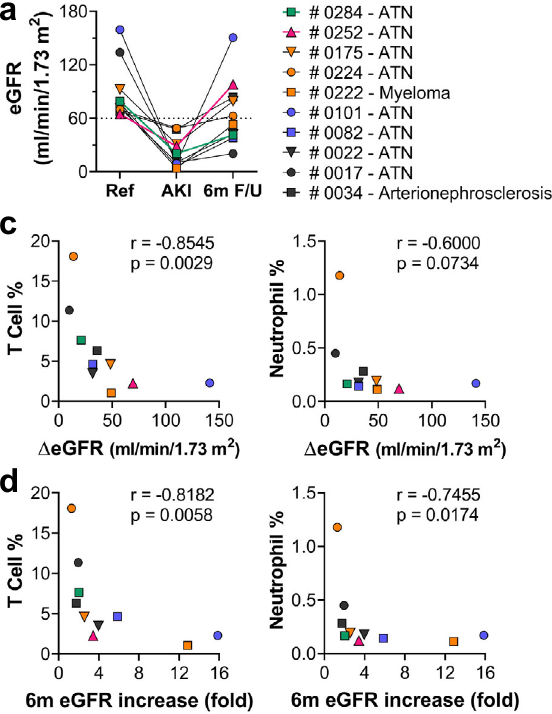
recovery of GFR, green square in a ], and a healthy living donor are shown. Scale bars, 50 µ m. c Correlation between absolute eGFR increase ( Δ eGFR) within 6monthsafterbiopsyandT-cellin fi ltrate(%)orneutrophilin fi ltrate(%)atthetime of AKI biopsy was determined by nonparametric Spearman correlation coef fi cient r . d CorrelationbetweenrelativeeGFRincrease(foldchange)within6months(6m) afterbiopsyandT-cellin fi ltrate (%)orneutrophilin fi ltrate(%)atthetimeofbiopsy was determined by nonparametric Spearman correlation coef fi cient r